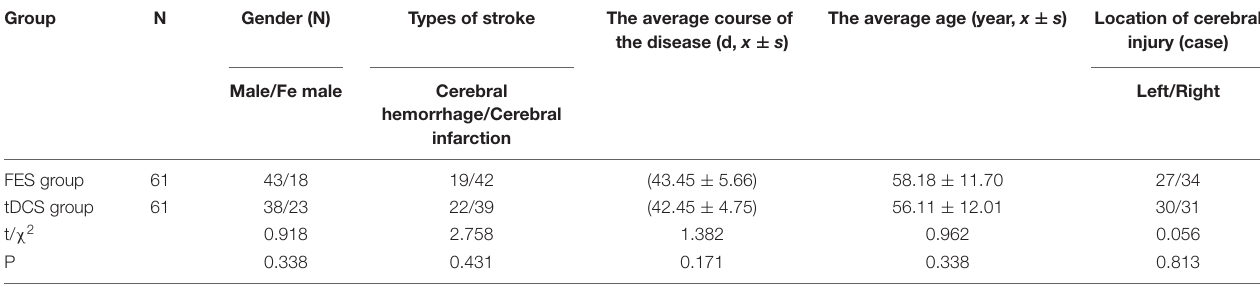
TABLE 1 | Comparison of patients’ baseline data. Group N Gender (N) Types of stroke The average course of